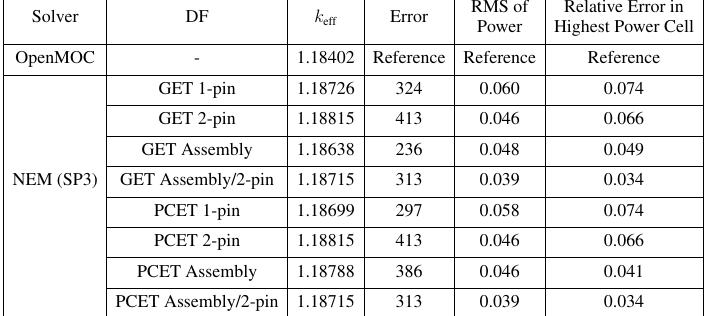
Table 3: Comparison of Different DFs in C5G7 Benchmark with P0 XS